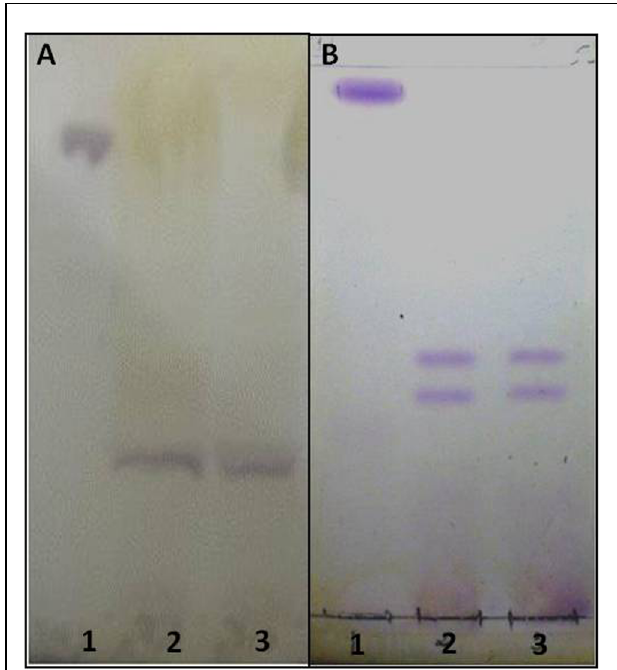
FIGURE 1 | High resolution thin layer chromatography (HPTLC) of acidic GSLs purified from the crude lipid extract of Paracoccidioides brasiliensis . The solvents used were CHCl 3 :CH 3 OH:CaCl 2 0.02% in the proportions 60:40:9 (v/v/v). Revelation with 0.5% orcinol in 3 M sulfuric acid (H 2 SO 4 ). (A) - (1) Standard CMH, (2) purified acidic GSL (3) purified acidic GSL. (B) - (1) Standard CMH, (2) purified acidic GSL Standard Acidic, (3) purified acidic GSL (B) . The glycolipids purple